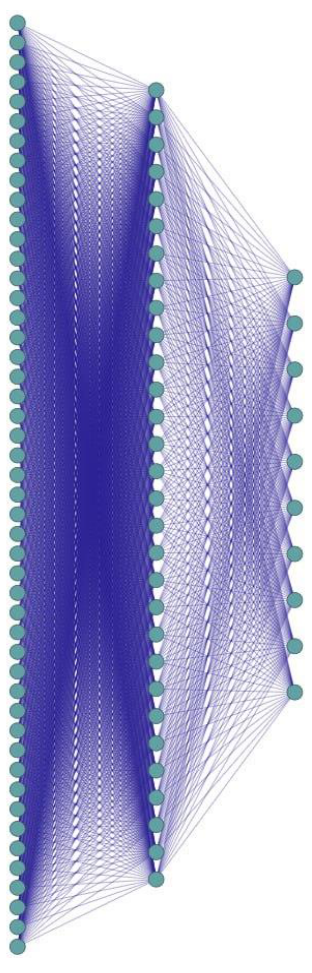
Figure 17. Neural network structure.